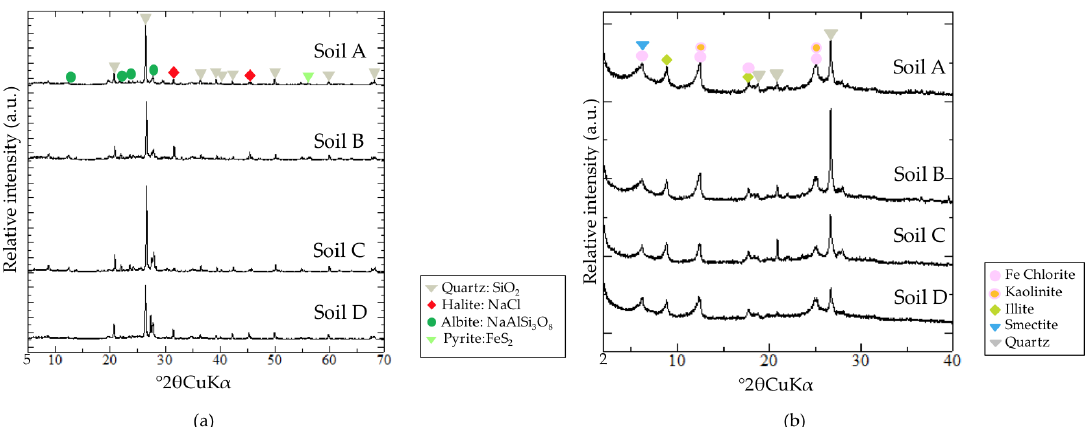
Figure 4. XRD profiles of ( a ) randomly oriented dredged soil samples to detect mineralogical phases and ( b ) oriented dredged soil samples to detect clay mineralogical phases.